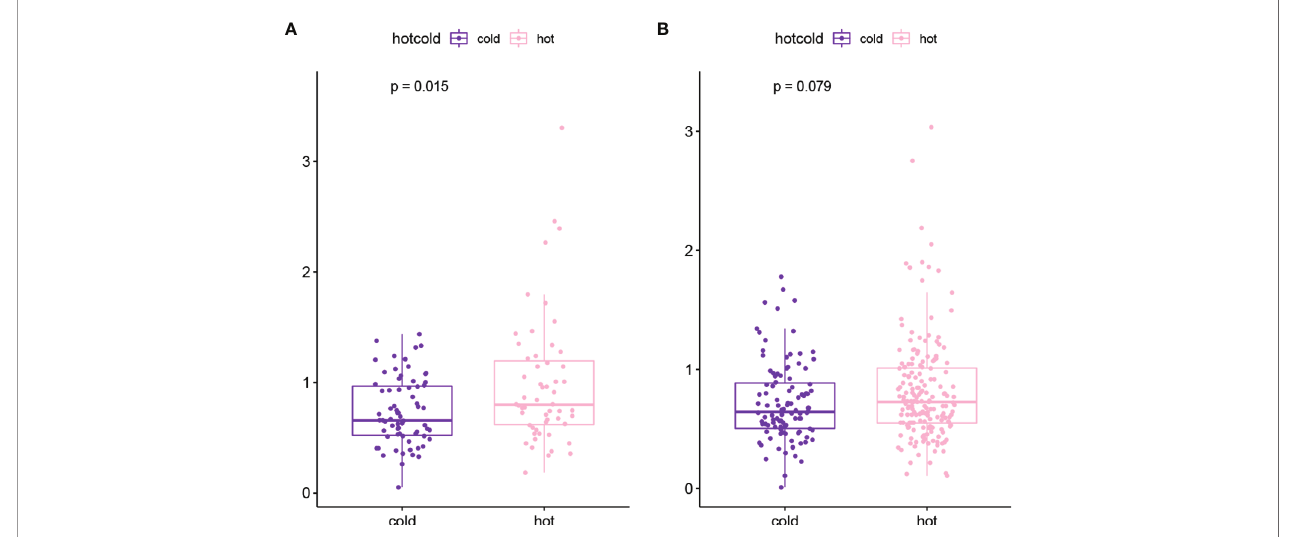
FIGURE 4 | The TMB value of hot tumor group and cold tumor group in chemotherapy (A) and non-treatment (B) groups.